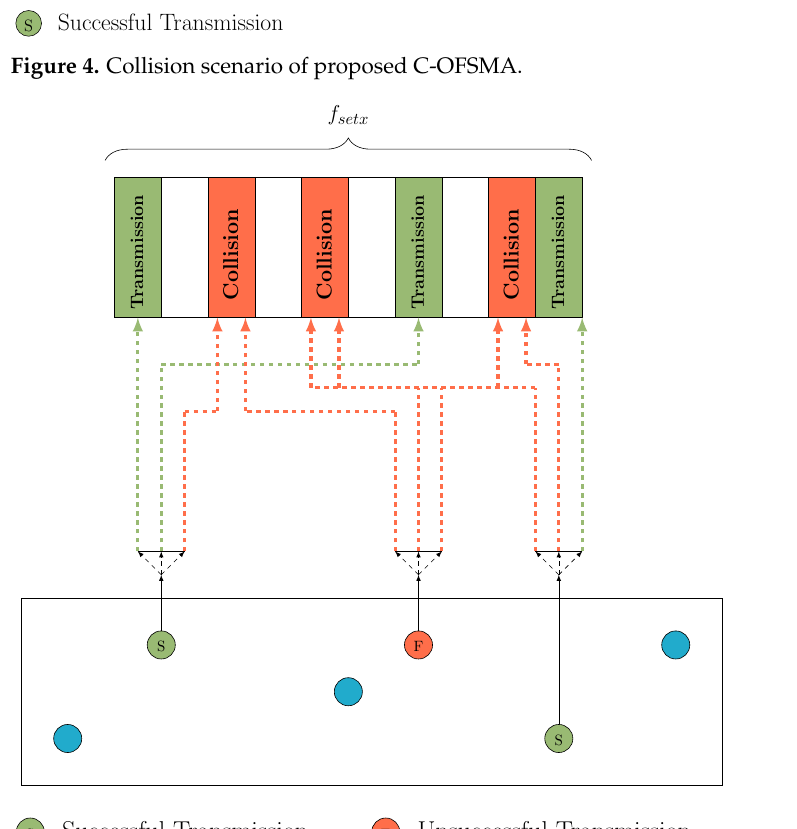
Figure 5. Collision